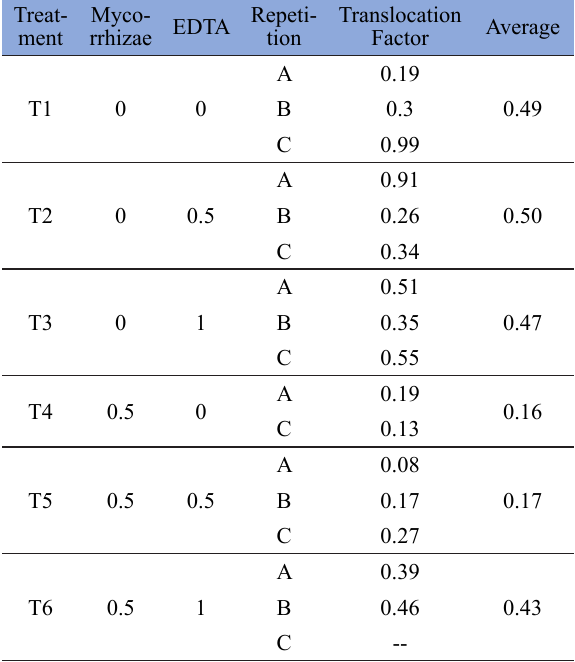
Table 7 : Translocation factors in each